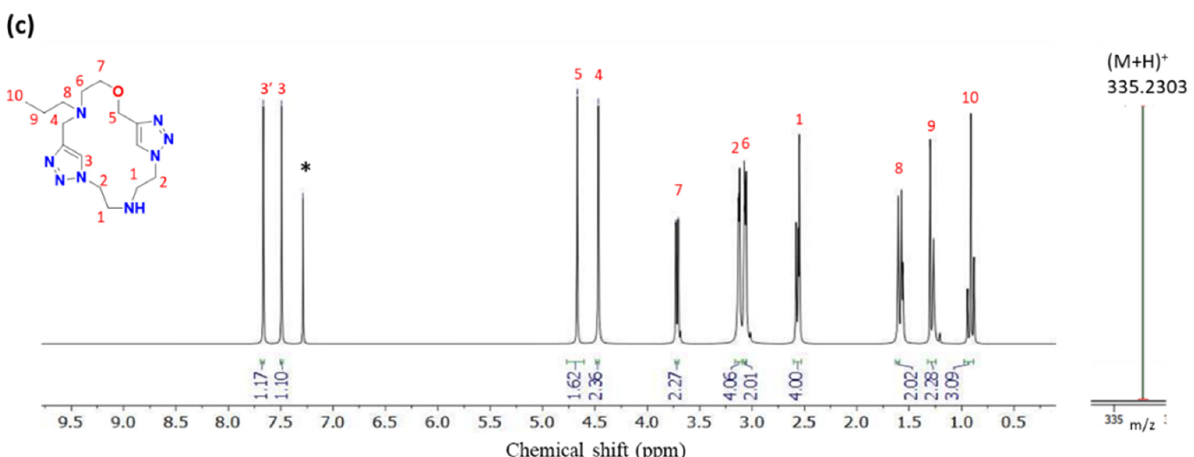
Figure 2. ( a ) The synthetic scheme for macrocyclization reaction; ( b ) Structure of the synthesized macrocycles (ACN: Acetonitrile, CuI: Copper iodide, DIPEA: Diisopropylethylamine, rt: Room temperature); ( c ) Characterization by 1 H NMR and HRMS. Left, 1 H NMR of MC1 (“*” is the residual proton signal of solvent CDCl 3 ); right, High-resolution mass spectrum with the peak of [M+H] + . Calculated for C 15 H 26 N 8 O [M+H] + : 335.2308 Da; observed [M+H] + : 335.2303 Da.